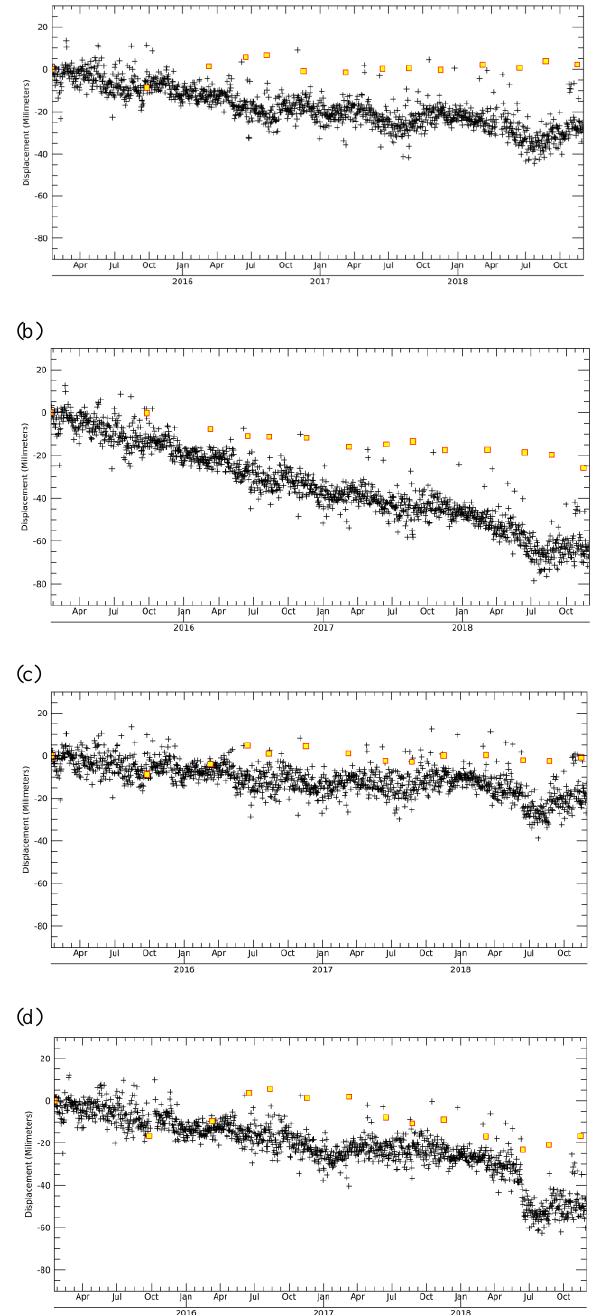
Figure 7. Comparison between the displacement calculated by the SBAS method and that obtained from GEONET data for (a) Shiroi, (b) Tomisato, (c) Ichihara, and (d) Chosei. The red squares and black pluses show SBAS and GEONET data,